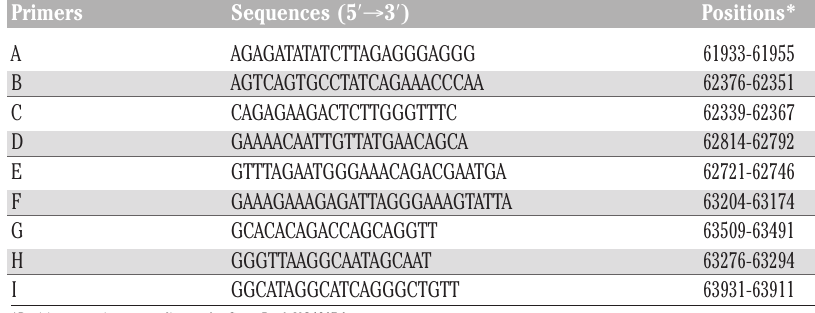
Table 1. Primers used for DNA sequencing of the β -globin gene with sequences and posi- tions in the β -globin gene cluster. Primers